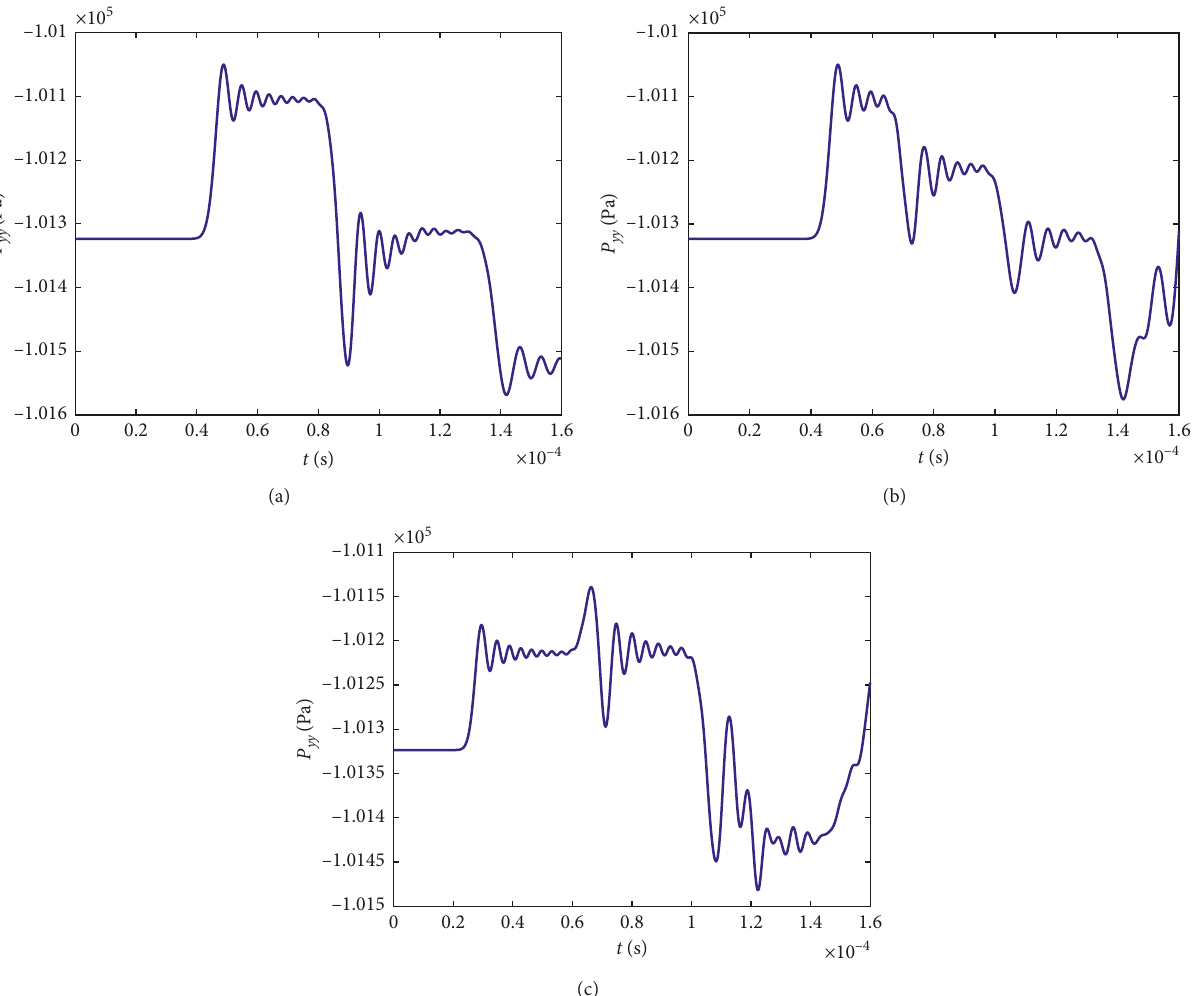
(or A ) of the specimen; (b) at the point A (or A ) 2mm from A (or A ) 1 2 3 4 1 2 (or A ) 2mm from A (or A ) up in the perpendicular direction, reprinted 8 9 1 7